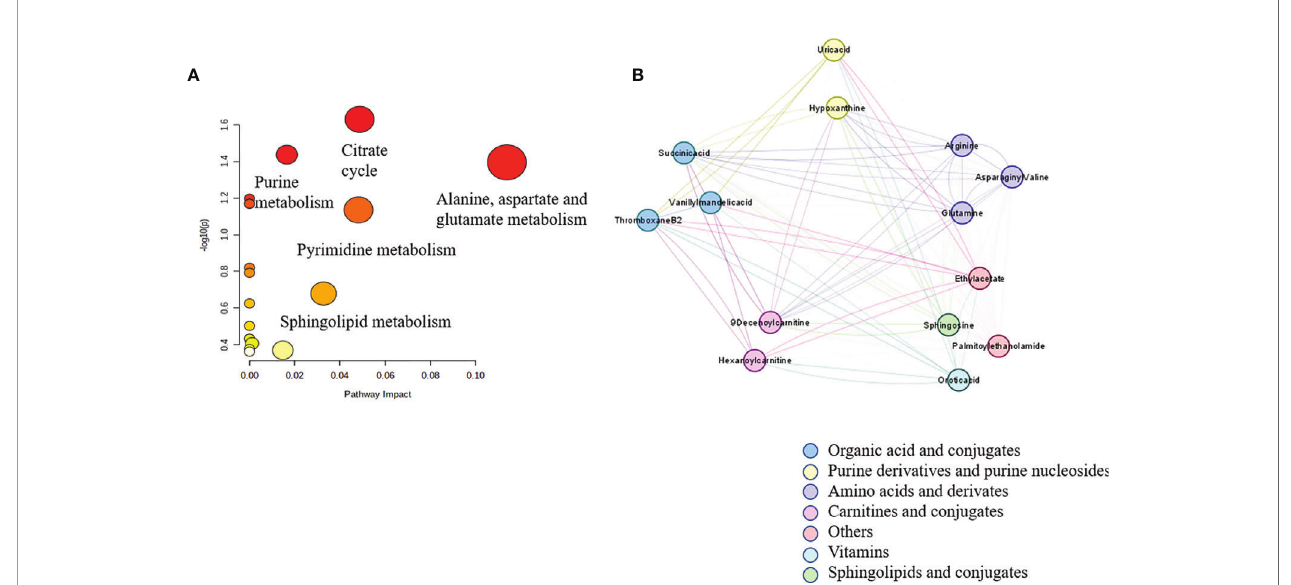
FIGURE 3 | Correlation network analysis of metabolites identi fi ed in untargeted metabolomics. Spearman ’ s correlation analysis of 14 signi fi cantly different metabolites in the plasma samples of the preoperative group and the postoperative group in graph (A) . The disturbed metabolic pathways showed various metabolism changes between the preoperative group and postoperative group in graph (B) .